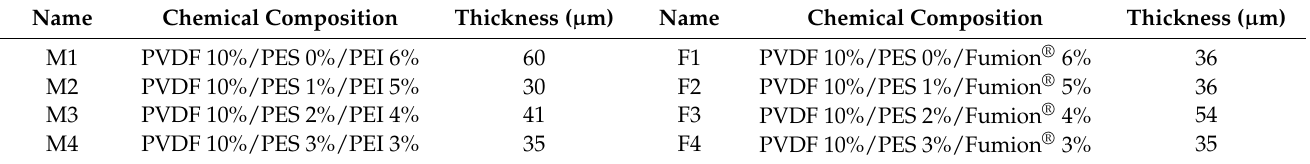
Table 1. Chemical composition and thicknesses of the membranes PVDF/PES and PEI or Fumion ®